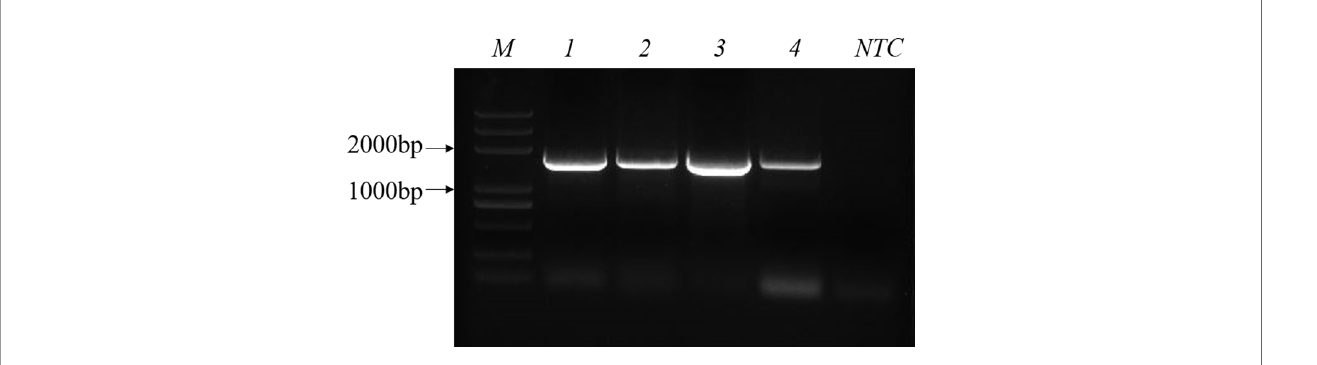
FIGURE 1 | Results of PCR agarose gel electrophoresis. M: Marker; 1 – 4: PPV-VP2 plasmid; NTC: negative control with ddH